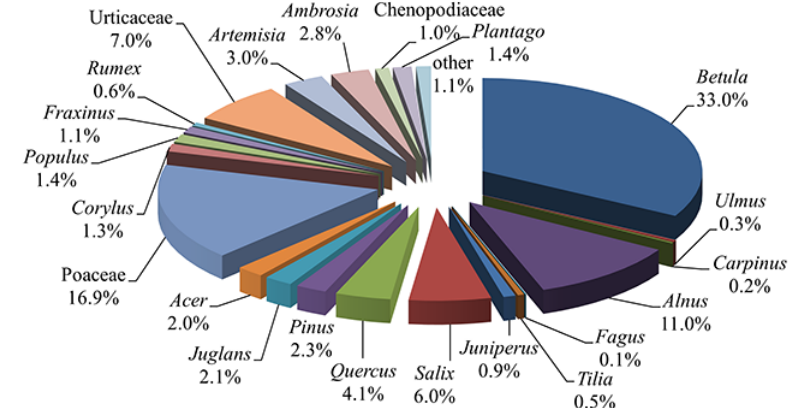
Figure 4 Aeropalynological spectrum of Ivano-Frankivsk in 2014.